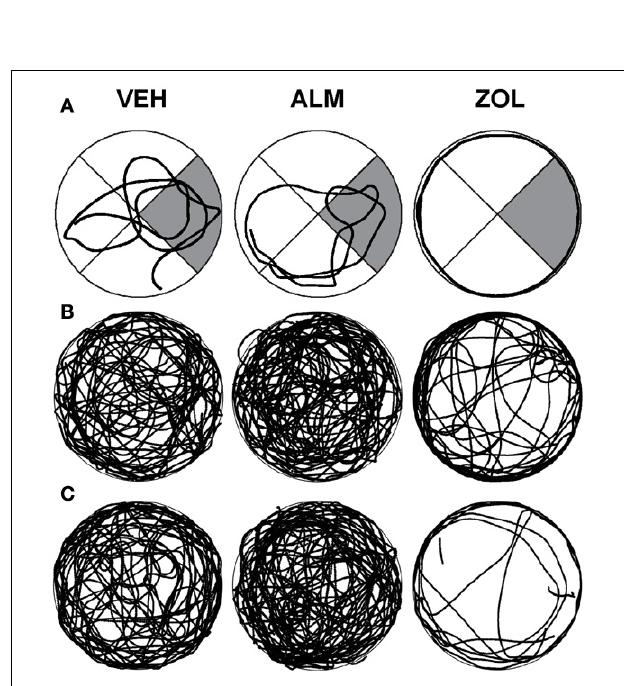
FIGURE 3 | Measures of performance in the spatial reference memory task. For all measures, ZOL-treated rats performed poorly compared to VEH- and ALM-treated rats. For all measures, the ALM-treated rats were indistinguishable from the VEH-treated rats.